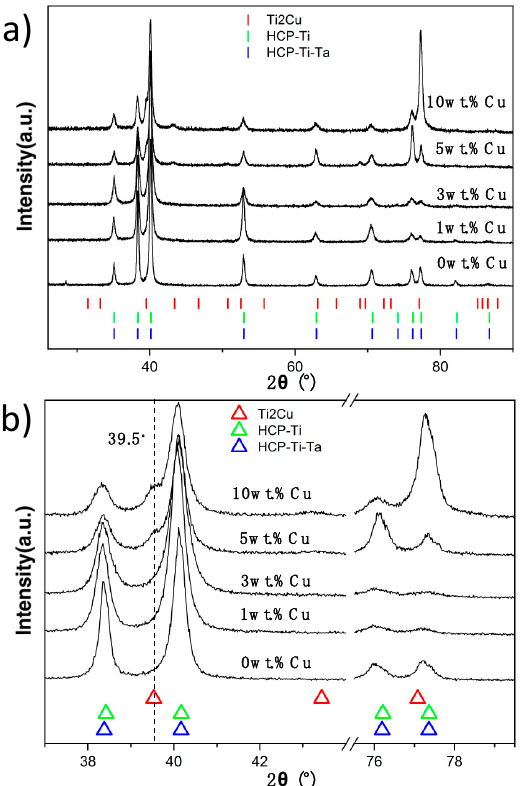
Figure 2. X-ray diffraction on TNTZ-Cu x alloys: ( a ) Diffraction for all alloys including references from Ti 2 Cu (04-003-1382), HCP- (Ti-Ta) (03-065-9616) and HCP-Ti (00-044-1294). ( b ) X-ray diffraction pattern showing the 2 θ angular ranges for the alloys from 38 ° –41 ° and 76 ° –78 ° . Note the Ti 2 Cu peak at 39.5°.